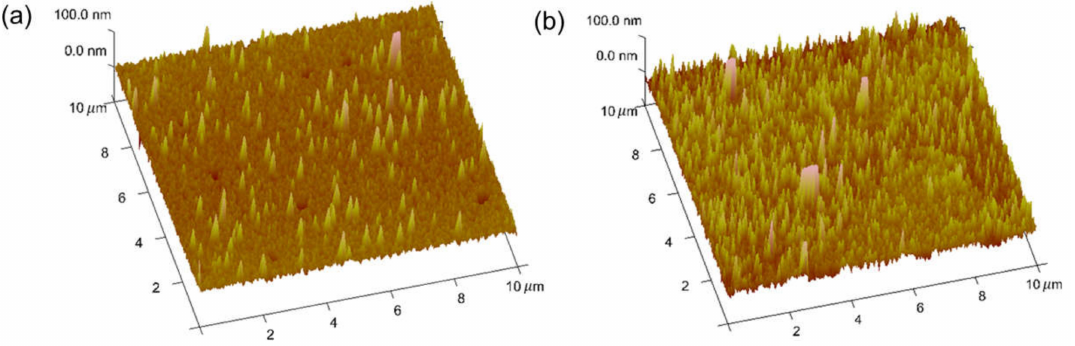
Figure 3. AFM image analysis of the ( a ) bare and ( b ) antibody-immobilized Ag gate